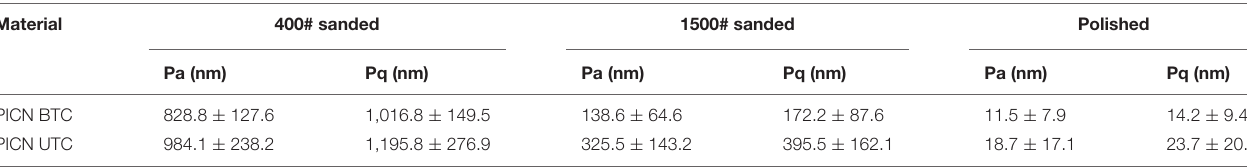
FIGURE 4 | Microstructures of sanded and polished surfaces of composites. (a) 400# sanded PICN BTC. (b) 1500# sanded PICN BTC. (c) Polished PICN BTC. (d) 400# sanded PICN UTC. (e) 1500# sanded PICN UTC. (f) Polished PICN UTC. TABLE 3 | Surface roughness values of sanded and polished